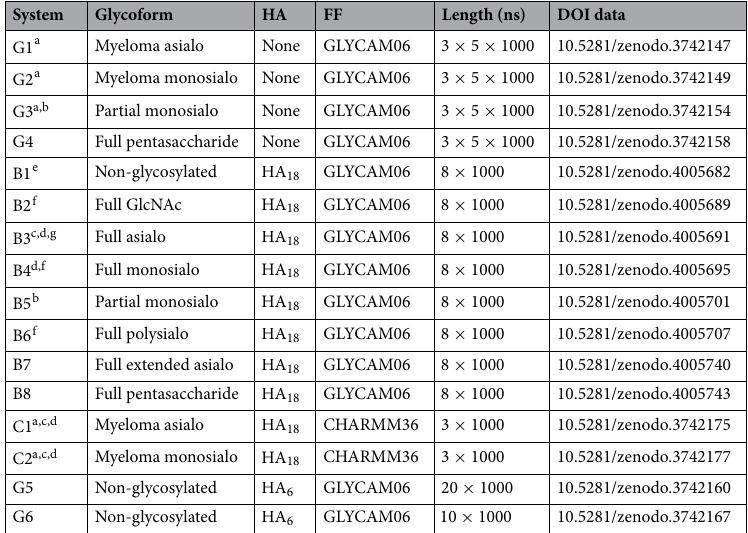
Table 2. List of simulated systems. Glycoform tells the N-glycan content on the CD44 HABD in each system. HA tells whether HA was present and which kind. FF lists the simulation force field. Length lists the duration of the simulations. Glycoforms of CD44 were experimentally found in: a Ref. 26 , b Ref. 19 , c Ref. 9 , d Ref. 18 , e Ref. 24 , f Ref. 16 , and g Ref. 17